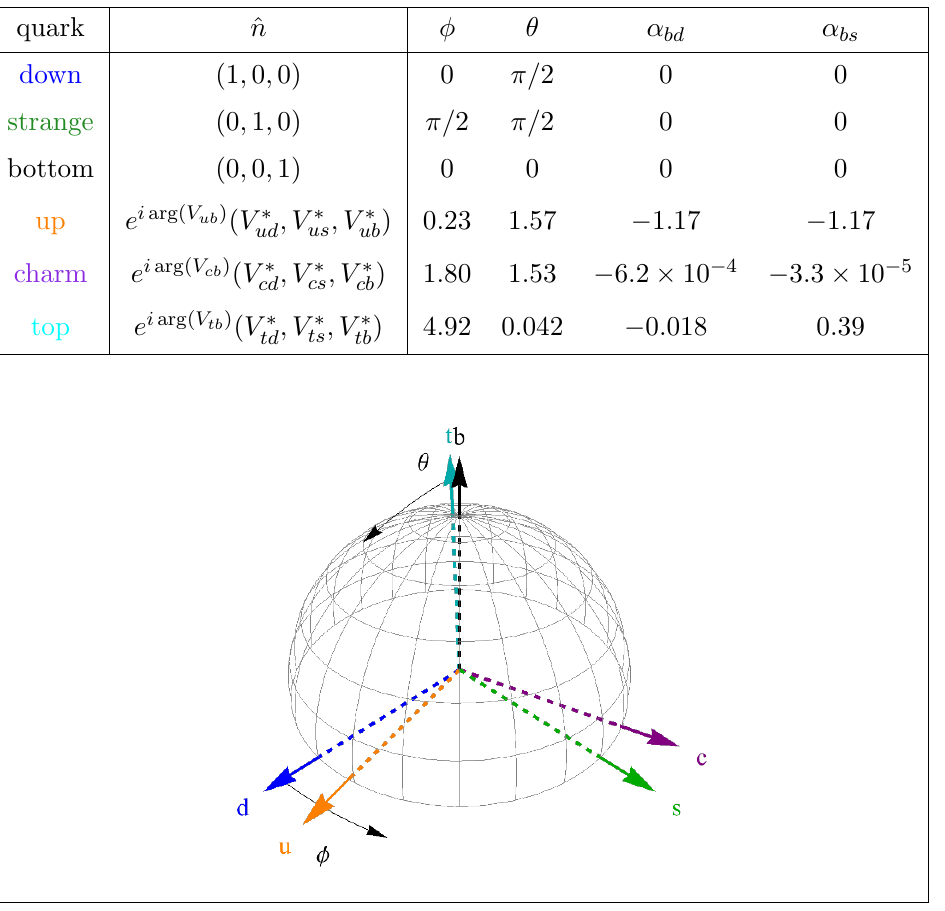
Table 2 . SM quark directions of the unitary vector ^ n i . The plot shows the corresponding directions in the semi-sphere described by the two angles ( (cid:18); (cid:30) ).